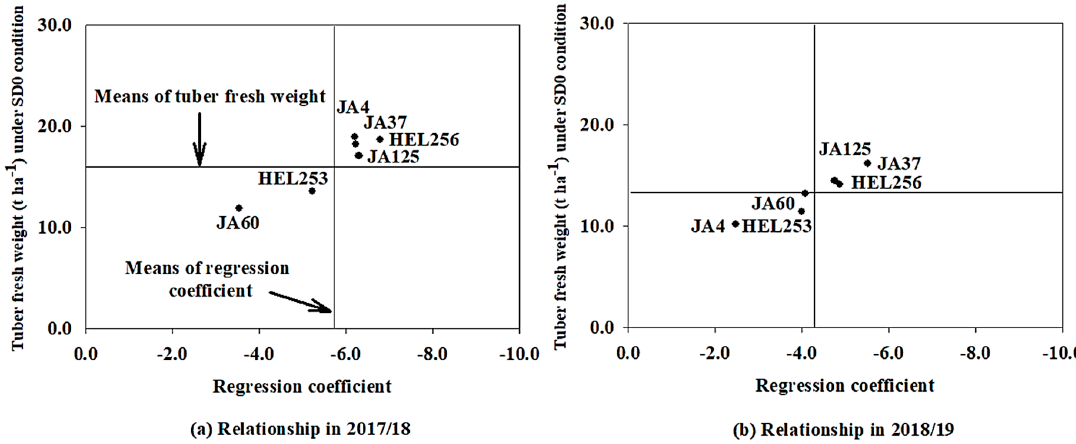
Figure 4. Regression coefficient (b-values) for tuber fresh weight of six JA genotypes under SD0 (no drought) in years 2017/18 ( a ) and 2018/19 ( b ).